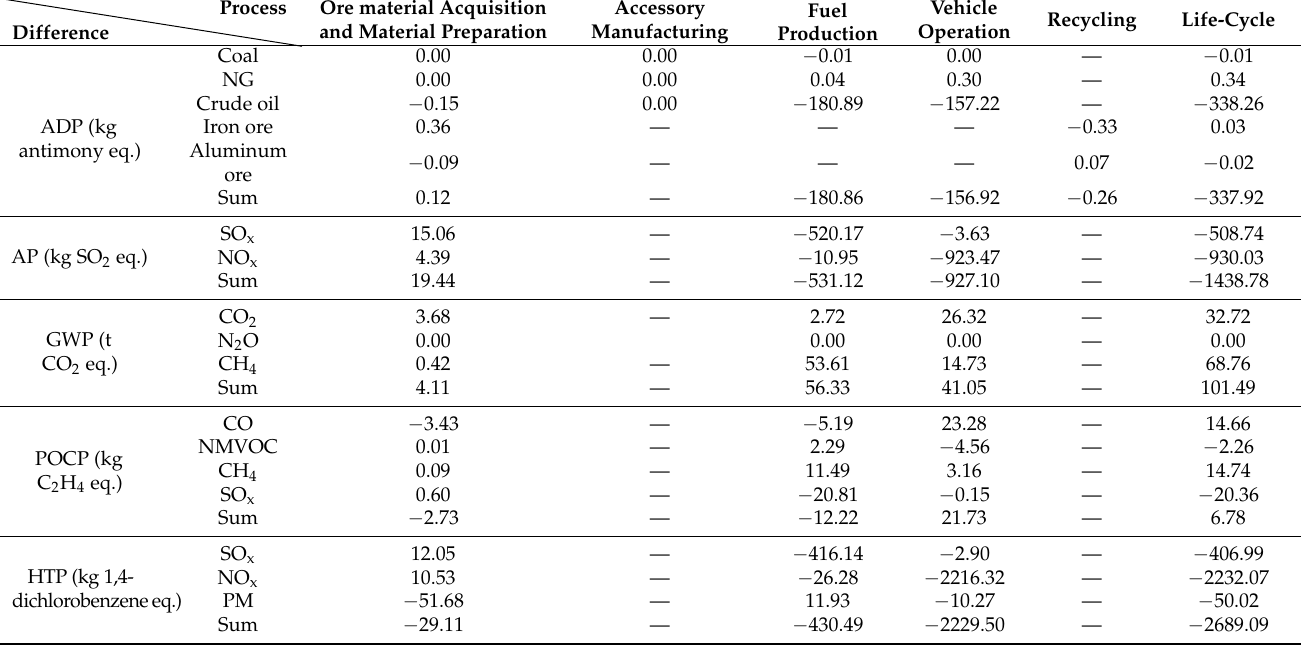
Table 7. Environmental impacts of LNG tractor-trailer compared to diesel